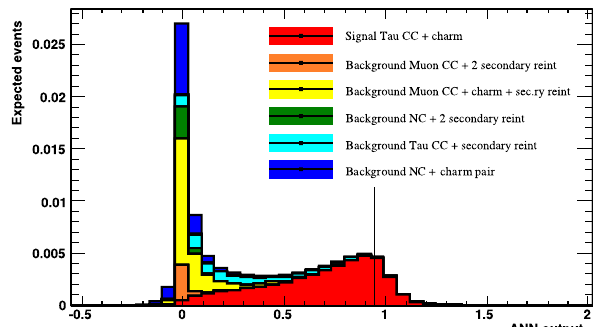
Fig. 7 Distribution of the ANN output variable. The weighted contri- bution of each process listed in Table 5 is shown with a different color. The vertical black line represents the ANN output for the event